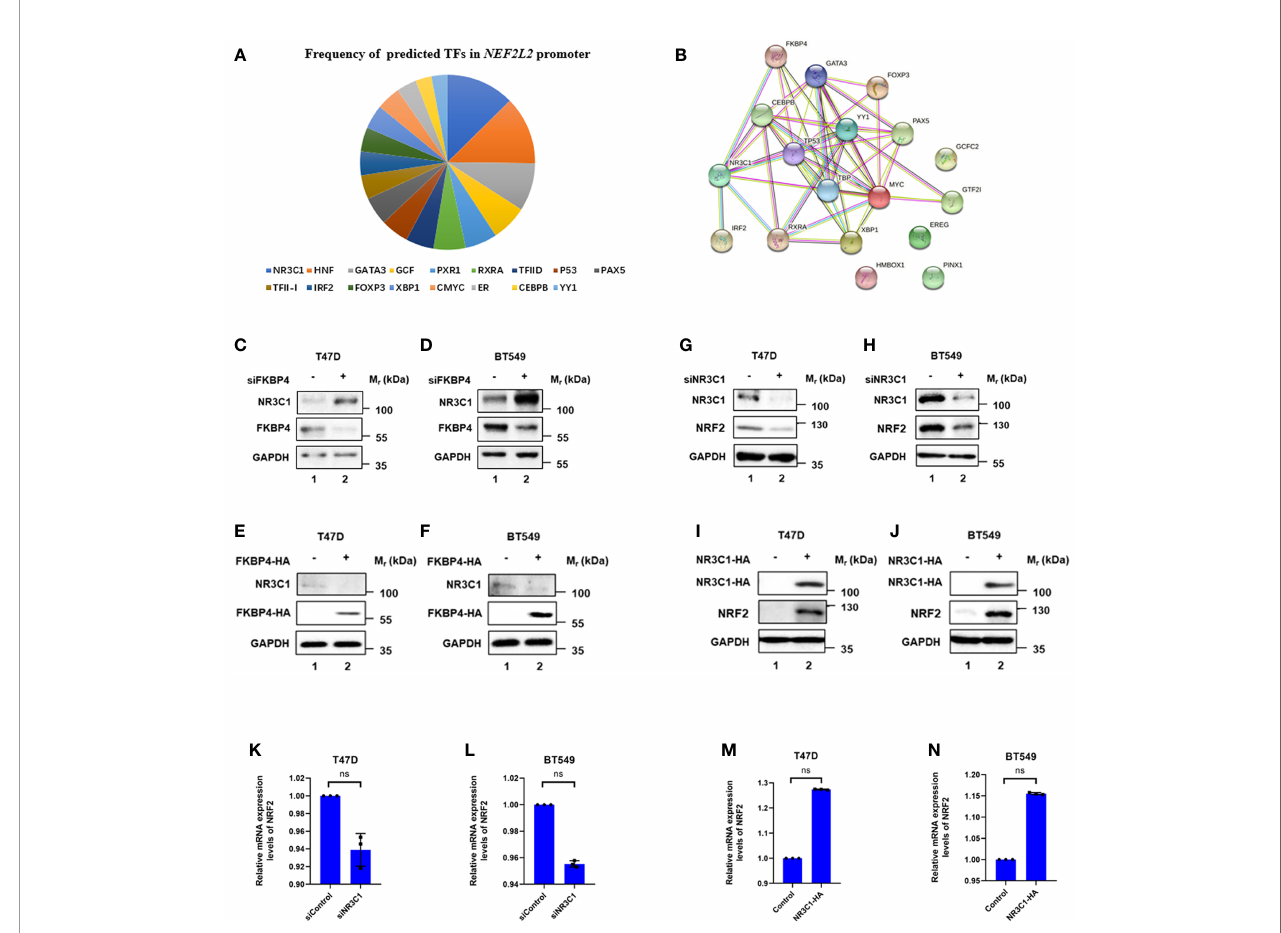
FIGURE 2 | FKBP4 regulates NRF2 via NR3C1. (A) Pie chart showed frequency of 17 predicted transcription factors in NRF2 promoter. (B) Protein to protein interacting network of FKBP4 and 17 putative NRF2 transcription factors. (C – F) Representative western blot analysis results of FKBP4, NR3C1, and endogenous control GAPDH. Western blot analysis showed silencing FKBP4 resulted in upregulation of NR3C1, overexpressing FKBP4 resulted in downregulation of NR3C1 in T47D and BT549 cells. (G – J) Representative western blot analysis results of NR3C1, NRF2, and endogenous control GAPDH. Western blot analysis showed silencing NR3C1 resulted in downregulation of NRF2, overexpressing NR3C1 resulted in upregulation of NRF2 in T47D and BT549 cells. (K – N) RT-qPCR showed silencing NR3C1 resulted in no signi fi cant changes of NRF2, overexpressing NR3C1 resulted in no signi fi cant changes of NRF2 in T47D and BT549 cells (n = 3 independent biological replicates). ns,